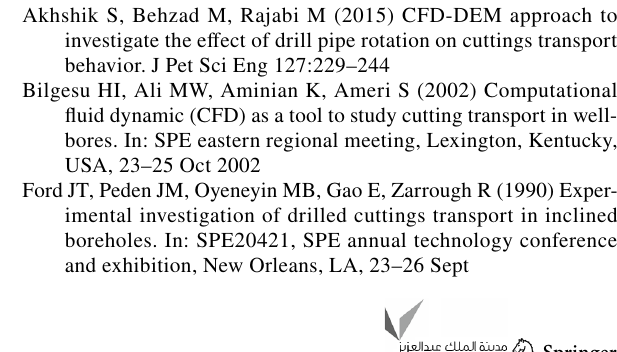
Pressure drop Shear stress along the applied on the wall